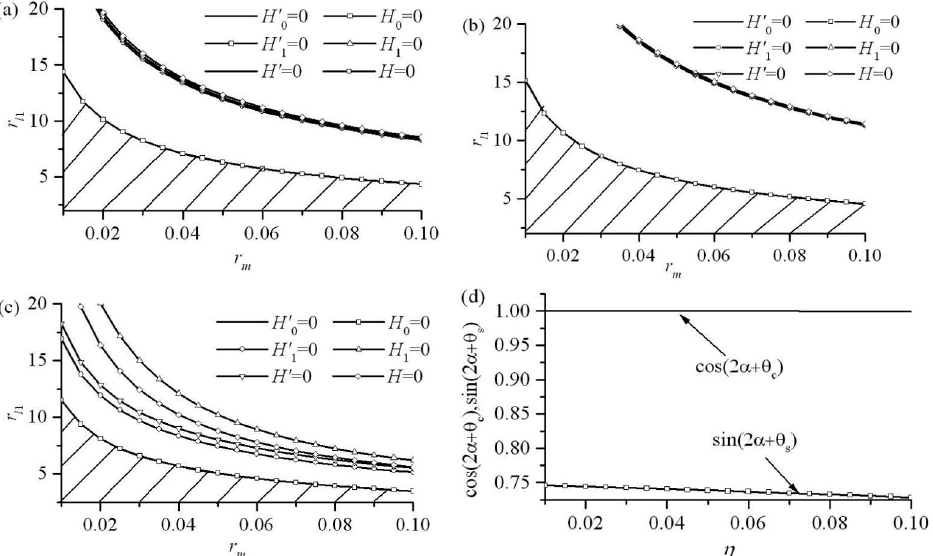
Fig. 2. Regions of stability of synchronization in r m r l 1 – plane for different parameters: (a) η = 0.5, r l 1 /r l 2 = 2, β 1 + β 2 = 2 π /3; (b) η = 1.0, r l 1 /r l 2 = 5, β 1 + β 2 = 2 π /3; (c) η = 0.8, r l 1 /r l 2 = 1, β 1 + β 2 = π /3; (d) values of cos 2 (2 α + θ c ) and sin 2 (2 α + θ s ) along the curve of H 0 = 0 in Fig.